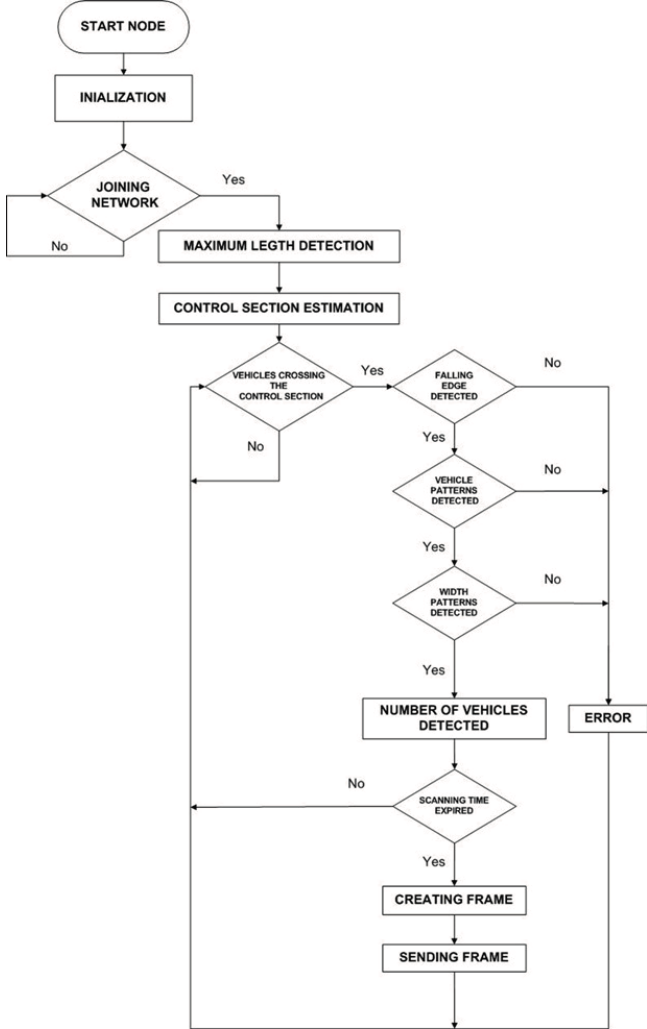
Figure 5. UIS ULT node